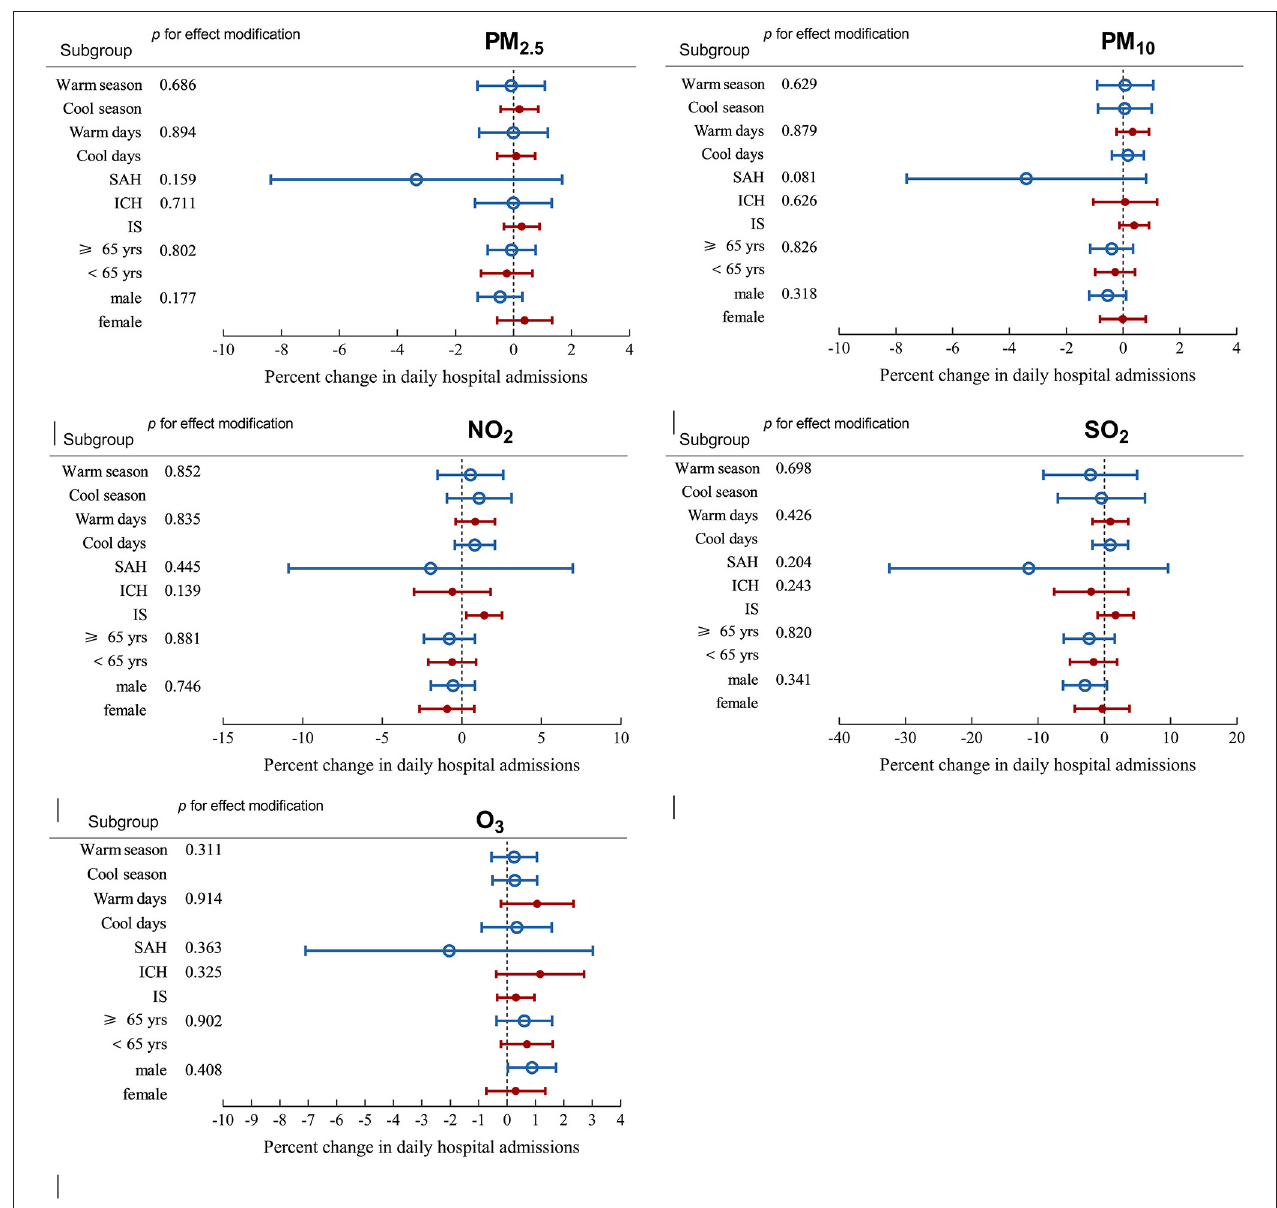
FIGURE 4 | Percentage changes with 95% CIs in hospital admissions for stroke with 10 µ g/m 3 increase in particulate matter with a diameter ≤ 2.5 µ m (PM 2.5 ), particulate matter with a diameter ≤ 10 µ m (PM 10 ), nitrogen dioxide (NO 2 ), sulfur dioxide (SO 2 ), and ozone (O 3 ) on lag 0 stratified by sex, age, apparent temperature, and season. The first column from the left in each panel indicates the subgroup and the second column indicates the P value generated from the Z test.